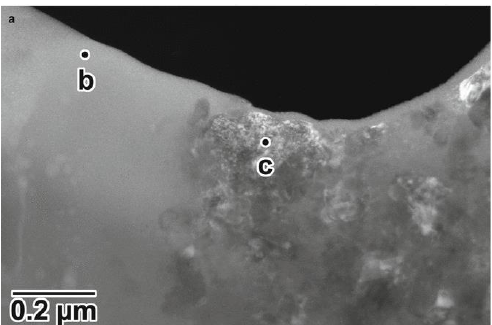
Figure 2. TiUnite™ implant: dark-field transmission electron micrograph of the depression on the surface. Reproduced with permission from [26], Copyright Springer, 2015.